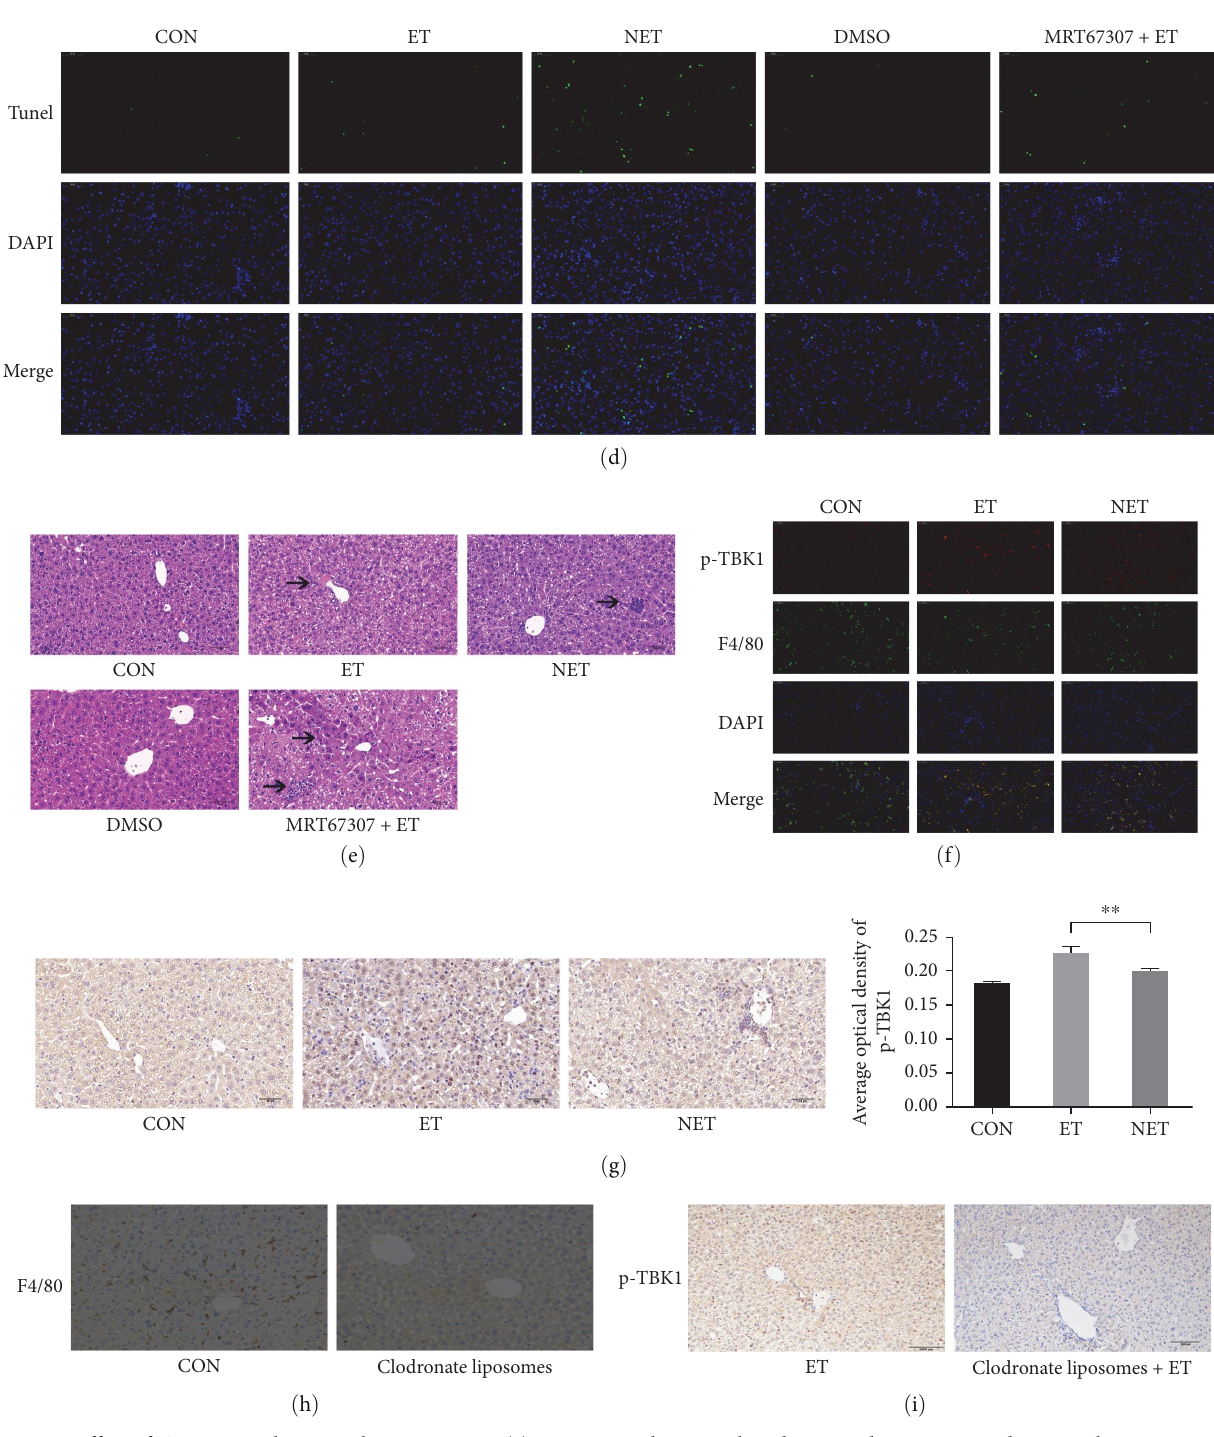
F IGURE 2: Effect of TBK1 on endotoxin tolerance in vivo: (a) ten mice in the control, endotoxin tolerance, nonendotoxin tolerance, DMSO, and TBK1-knockdown endotoxin tolerance were observed to plot survival curves. According to the log-rank test, p ¼ 0 : 0034; (b) serum AST and ALT levels in each group of mice re fl ect changes in liver function; (c) the level of IL-6 and IFN- β in serum was evaluated by ELISA; (d) TUNEL staining was used to detect the number of apoptotic cells; (e) H & E (400x) staining of the liver showed LPS-induced liver injury; (f) immuno fl uorescence staining showed that the phosphorylation level of TBK1 was increased in the ET group; (g) immunohistochemical staining (400x) was used to demonstrate TBK1 phosphorylation in the liver tissues of each group; (h) clodronate liposomes were used to delete Kupffer cells in the liver. The control liposome group was 200 μ l control liposome and the neutral liposome group was 200 μ l neutral liposome; (i) phosphorylation of TBK1 in liver tissue of ET and CL +ET (Kupffer cell-depleted mice) was detected by immunohistochemical staining (400x). Statistical signi fi cance was tested using the two-tailed Student ’ s t -test; data are presented as the mean Æ SD of at least three independent experiments; ∗ p < 0 : 05, ∗∗ p < 0 : 01, ∗∗∗ p < 0 : 001, ∗∗∗∗ p < 0 :